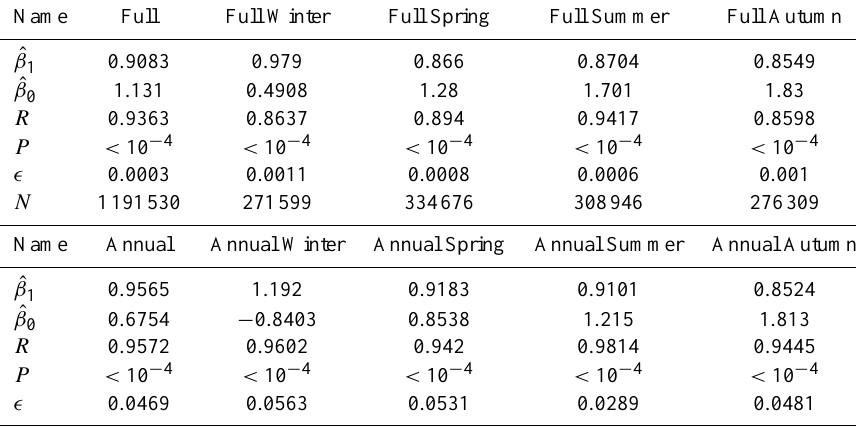
Table 1. Linear regression output parameters for temperature.